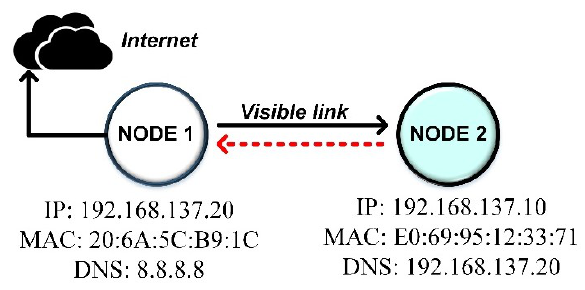
Figure 2. Point-to-point topology that consists of two nodes and address setting (Internet protocol,